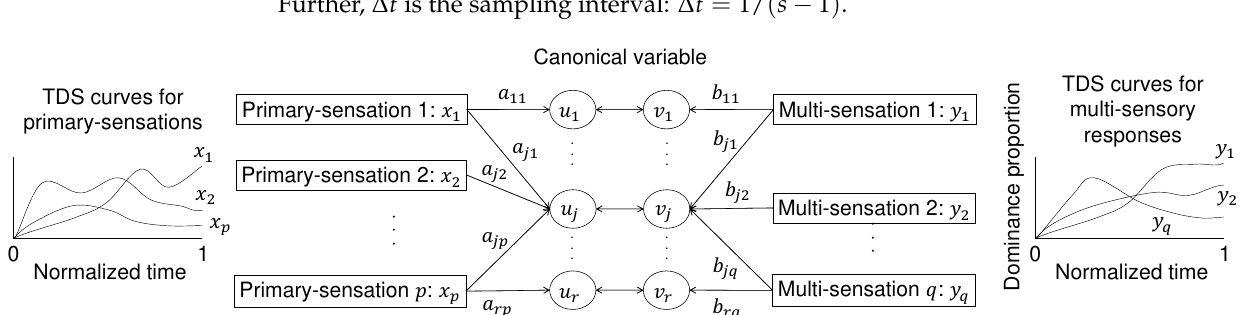
Figure 2. Schematic image of canonical correlation analysis (CCA). CCA connects p primary-sensory variables ( x ) and q multi-sensory variables ( y ) using the canonical variables u and v . The coefficients a j and b j were determined to maximize the correlation coefficient between u j and v j . j = 1, · · · , r ( r ≤ min ( p , q )